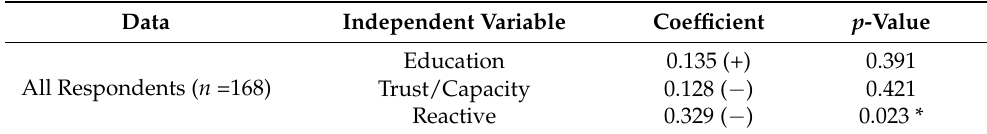
Table 6. Generalized linear model